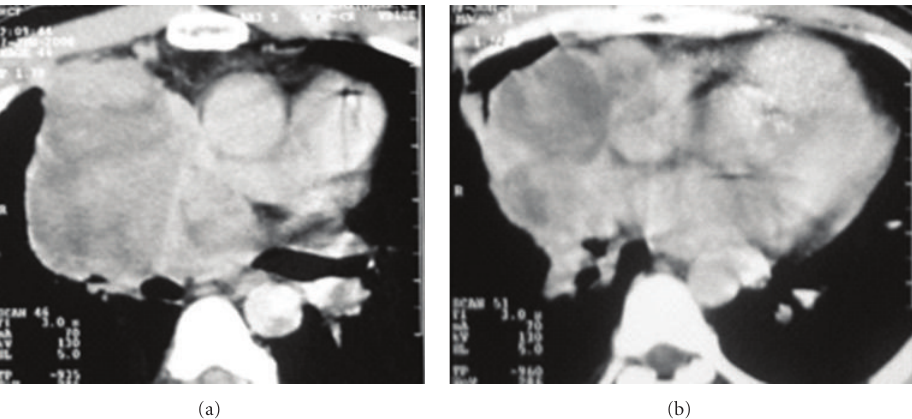
Figure 2: Axial post-contrast CT scan of the chest showing areas of necrosis in the mass with adherence to the